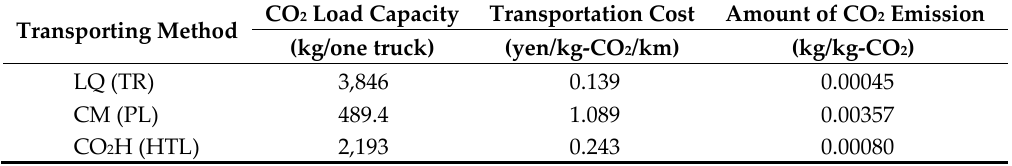
Table 9. Transportation results (CO 2 loading capacity and the transportation